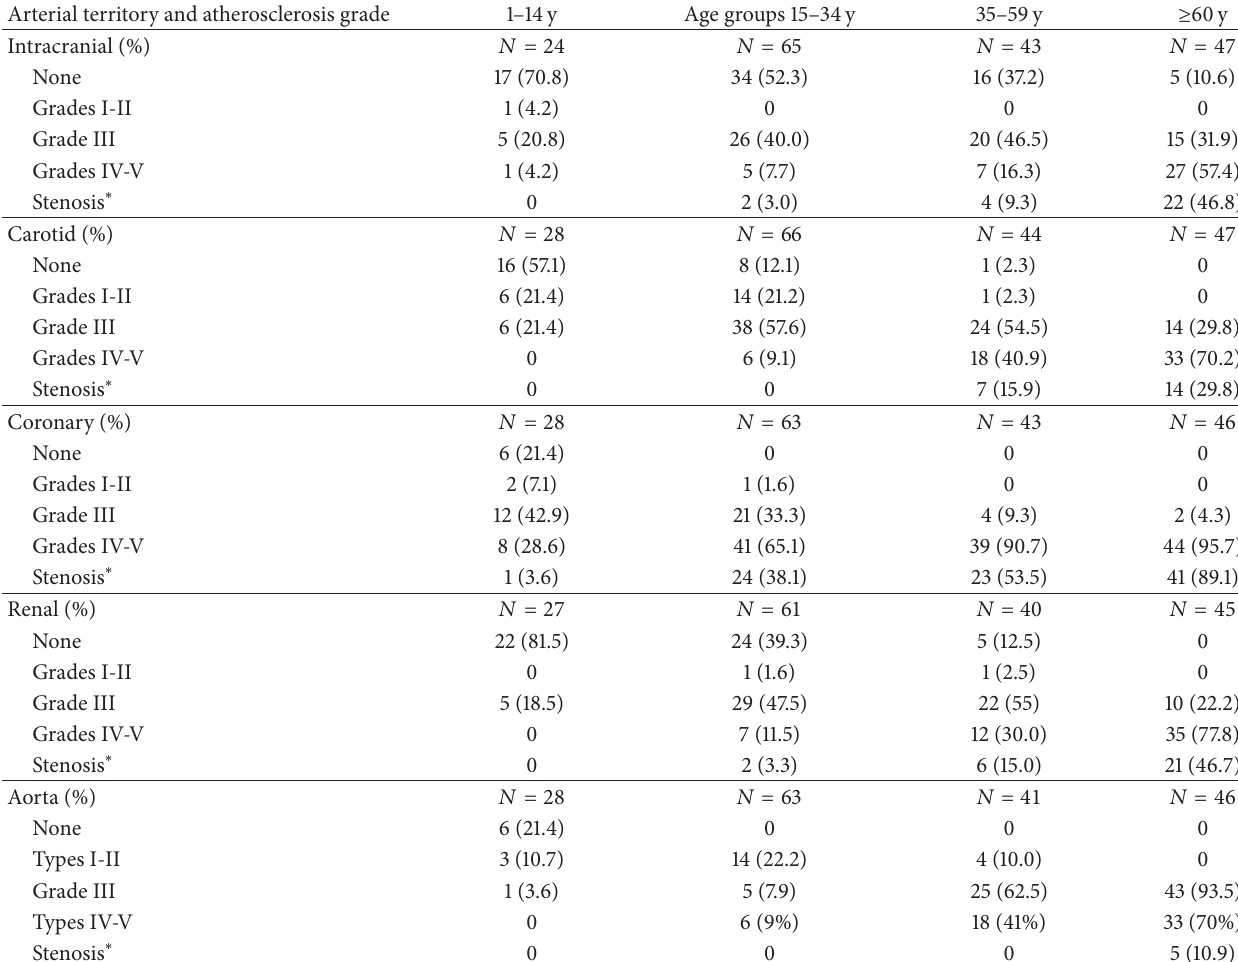
Table 2: Prevalence of atherosclerotic lesions by arterial territory and severity (AHA pathological classification) according to age groups. Arterial territory and atherosclerosis